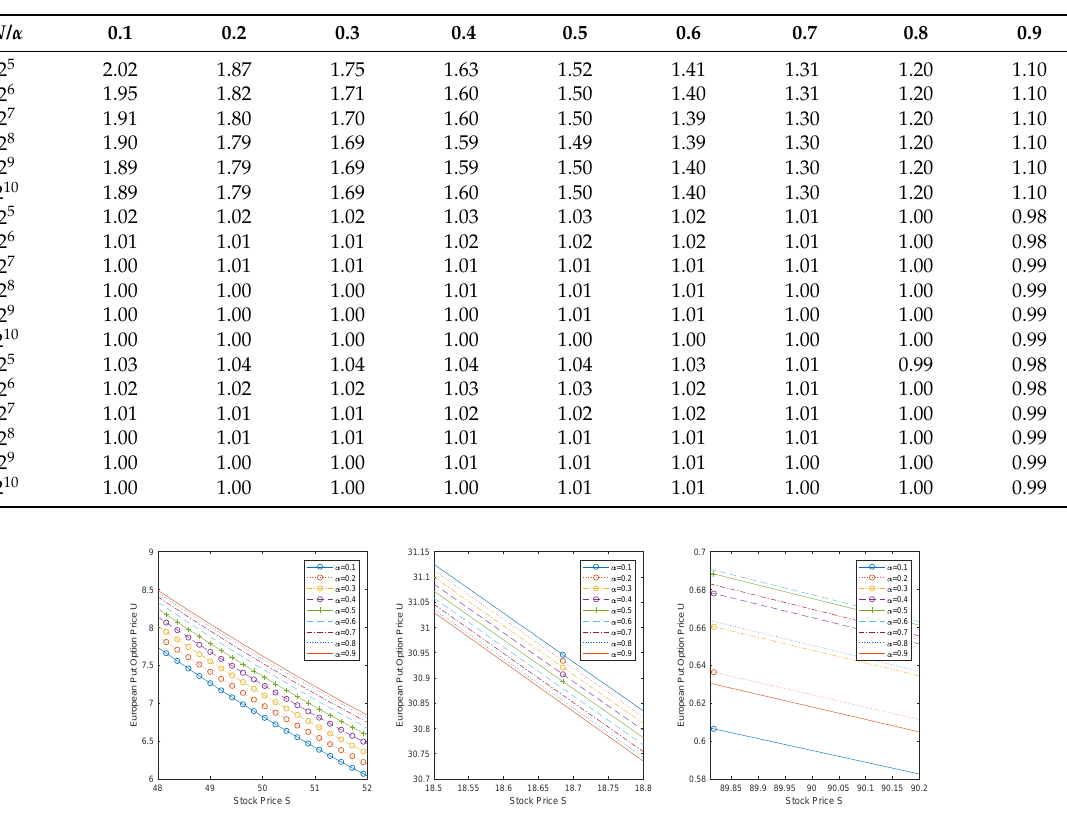
Figure 2. European put option prices at the terminal time T with M = N = 200 for different α values.